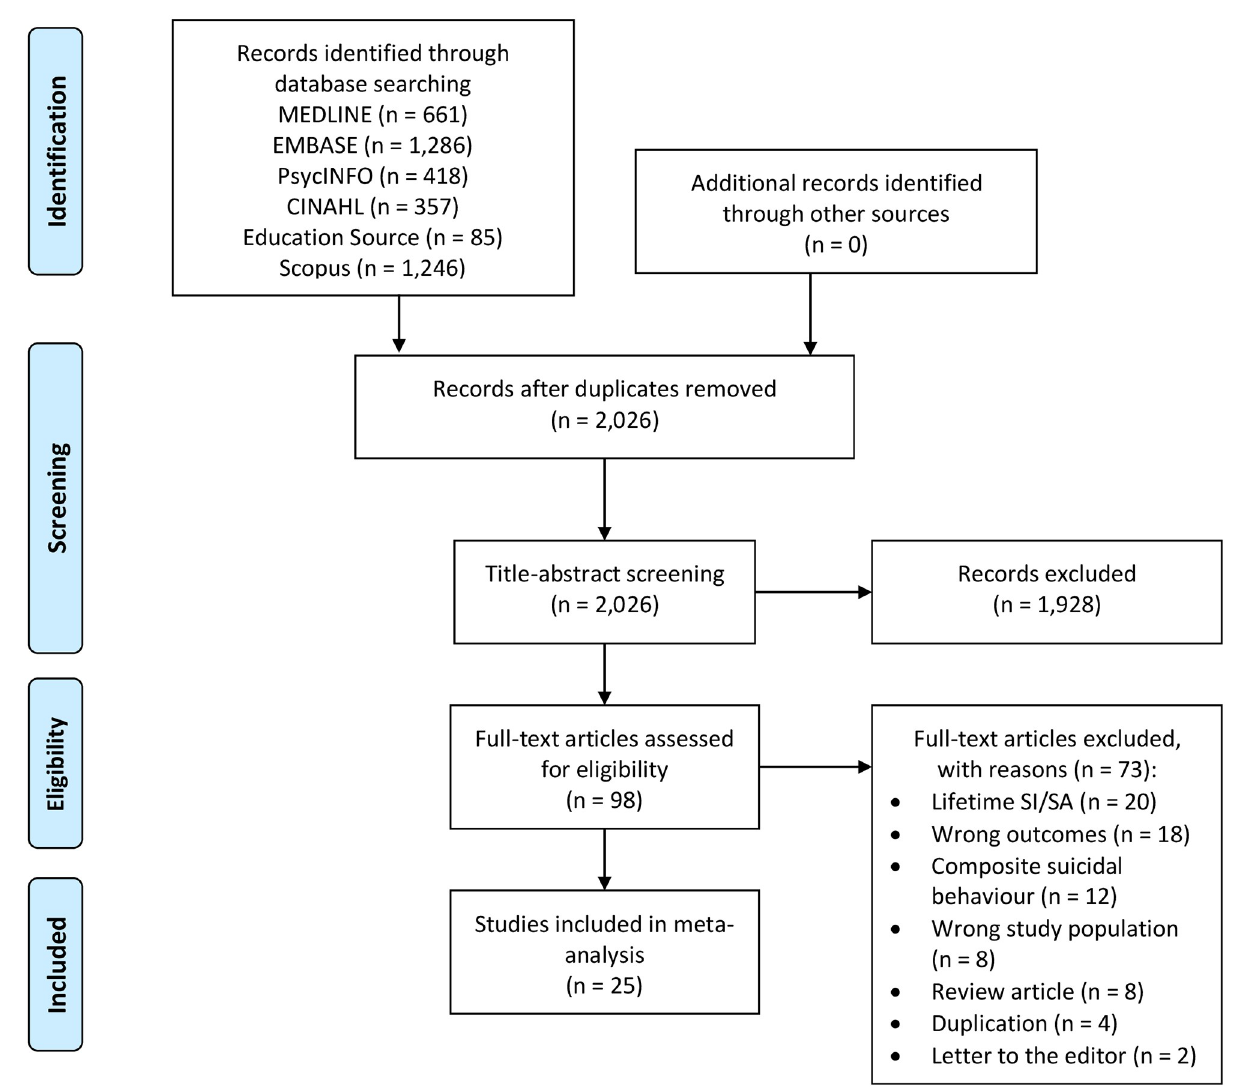
Fig 1. PRISMA flow diagram of the study screening